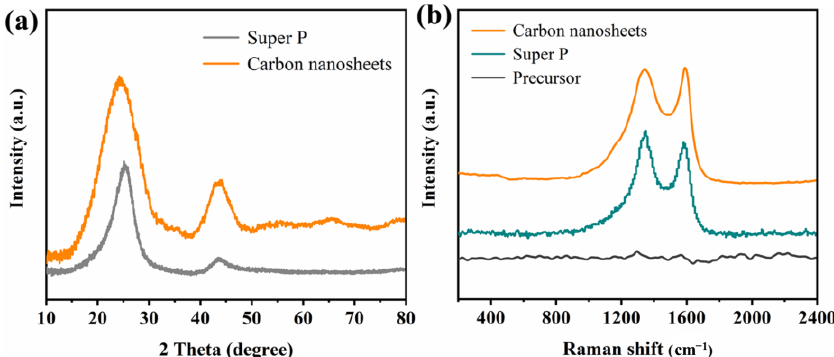
Figure 3. XRD ( a ) and Raman patterns ( b ) of carbon nanosheets and Super P.